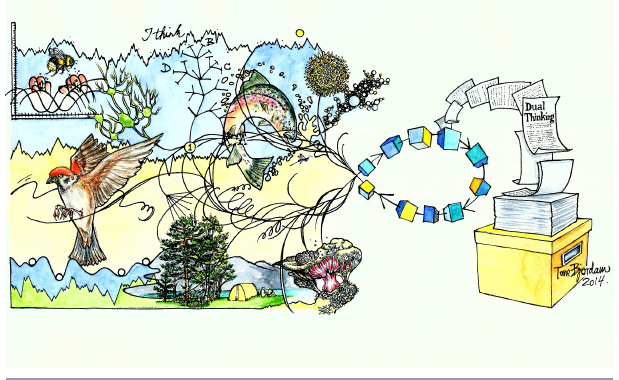
Fig. 1 . The process of dual thinking as envisioned by the Norwegian artist Tone Bjordam (http://www.tonebjordam. com/). Although the systematic reasoning process (system-II) depicted in the right-hand loop is emphasized in the way we teach science and organize our work, the associative left-hand loop (system-I) of the dual thinking process is usually hidden (Scheffer 2014). We argue that the working of this generator of novel ideas has always been essential for scientific breakthroughs and should be taught and catalyzed more explicitly in